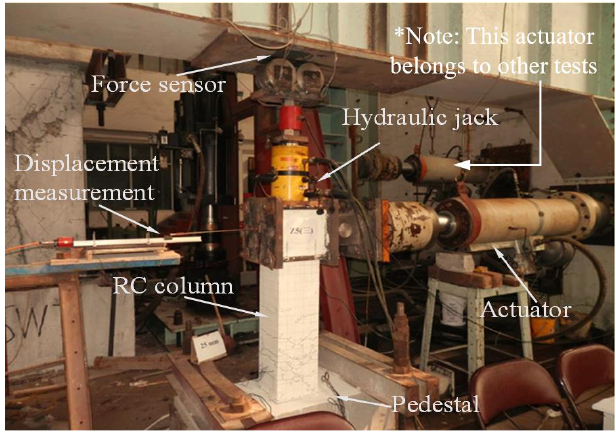
Figure 2. Experimental instrumentation.